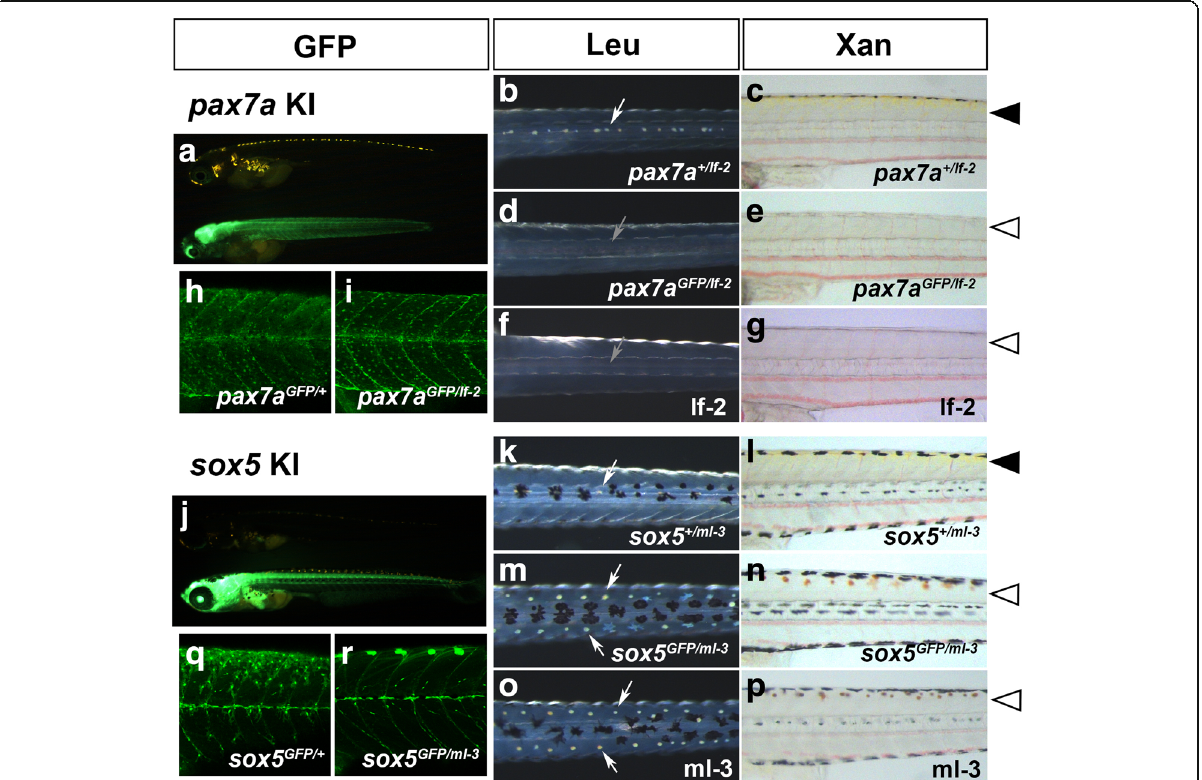
Fig. 5 Disruption of gene function by knocking-in pax7a and sox5. ( a - e , h - i ) Progenies (9 dpf) of a pax7a-transgenic founder crossed to an existing pax7a mutant, leucophore free 2 (lf-2, f - g ). ( j - n , q - r ) Progenies (9 dpf) of a sox5-transgenic founder crossed to an existing sox mutant, many leucophores 3 (ml-3, o - p ). ( a , h , i , j , q , r ) GFP. ( b , d , f , k , m , o ) Leucophores viewed in reflected light. ( c , e , g , l , n , p ) Xanthophores viewed in transmitted light. ( b , d , f , k , m , o ) Dorsal views of the trunk. ( c , e , g , h , i , l , n , p , q , r ) Lateral views of the trunk. ( h – i , q – r ) Confocal microscopy of the body surface of the nine dpf progenies. ( a , j ) Lateral views of pax7a-transgenic fish ( a ) and sox5-transgenic fish ( j ). A non-GFP (upper) and a GFP-positive (lower) larva are shown. Whereas the non-GFP larva ( pax7a +/lf-2 ) has leucophores in the dorsal midline ( b , white arrow) and shows yellow pigmentation in the skin ( c , arrowhead), presumably having xanthophores developing normally, the GFP-positive knock-in larva ( pax7a GFP/lf-2 ) fails to have leucophores ( d , grey arrow) or show yellow pigmentation ( e , open arrowhead). An lf-2 larva shows the pax7a loss-of-function phenotypes ( f , g ). Whether having a pax7a knock-in GFP allele with a wild-type allele ( h , heterozygote) or with an lf-2 allele ( i , homozygote), the larva has GFP/pax7a-positive progenitors on the surface of the trunk. As shown in B and C, the non-GFP offspring obtained from the sox5-transgenic founder shows normal pigmentation ( k , white arrow; l , arrowhead). The GFP-positive larva has excess leucophores bilaterally along the dorsal midline ( m , arrows) and lacks yellow pigmentation ( n , open arrowhead), as does the ml-3 mutant ( o , p ). While sox5 heterozygous larva ( q , sox5 GFP/+ ) has GFP-positive presumable xanthophore progenitors on the surface of the trunk, sox5 homozygote ( r , sox5 GFP/ml-3 ) lacks GFP-positive cells in the corresponding